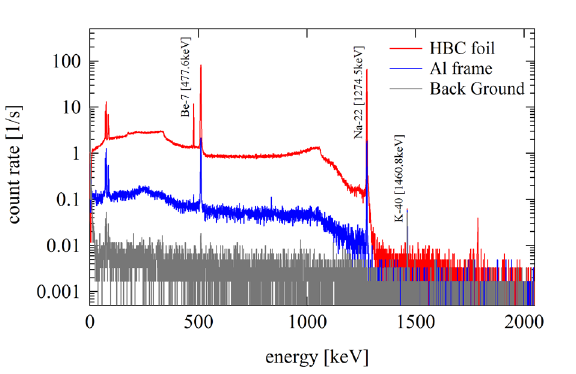
Fig. 9. Gamma-ray spectra in collected foil and